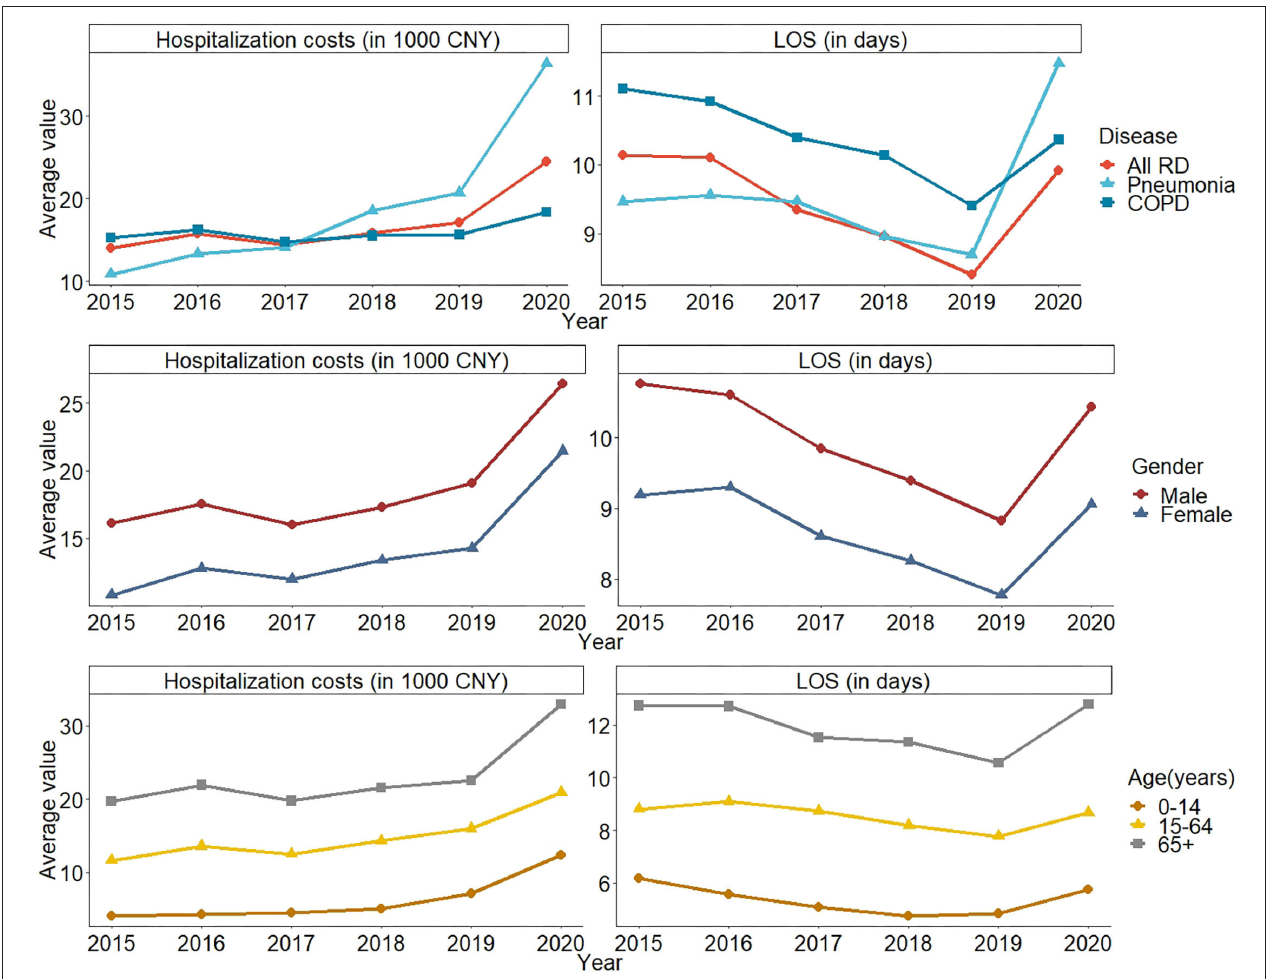
FIGURE 2 | The trend of average hospitalization costs and LOS due to RD in Wuhan, China from 2015–2020 by disease, gender, and age group.